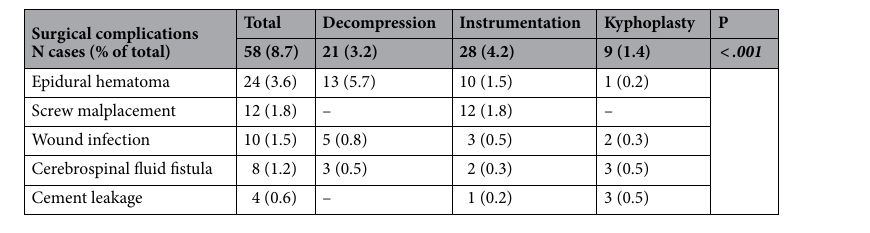
Table 5. Proportions of surgical complications needing revision surgery, total and stratified by initial procedure type.